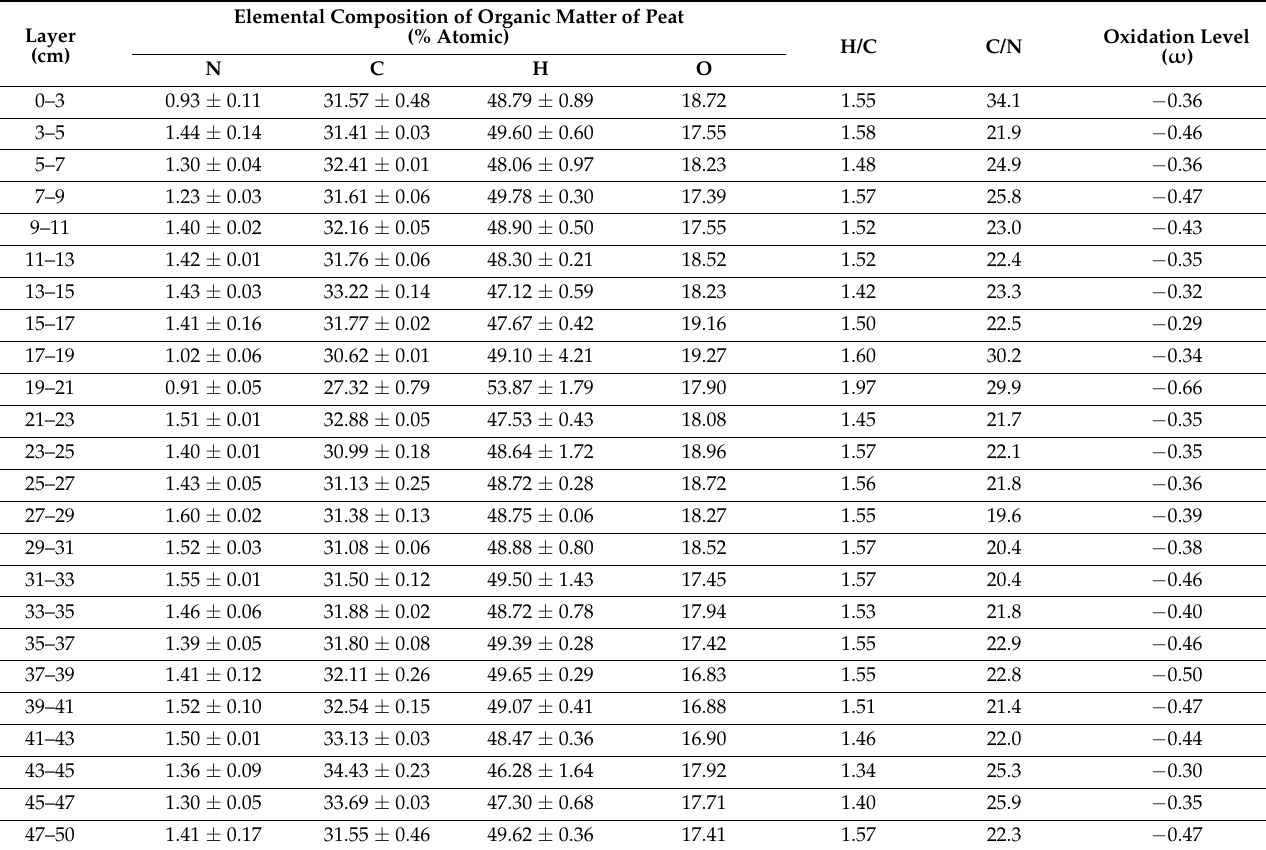
Table A3. Change in the elemental composition of peat by depth.